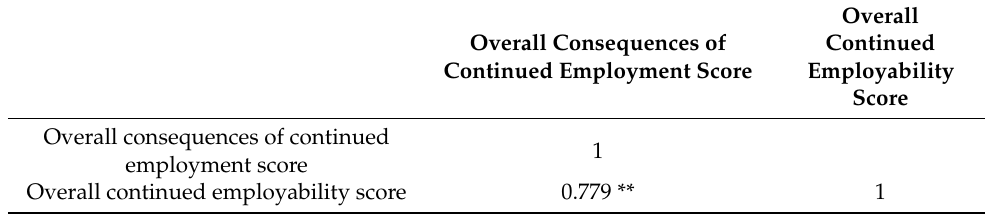
Table 6. Correlation between Continued Employability Scale and consequences of continued employment.